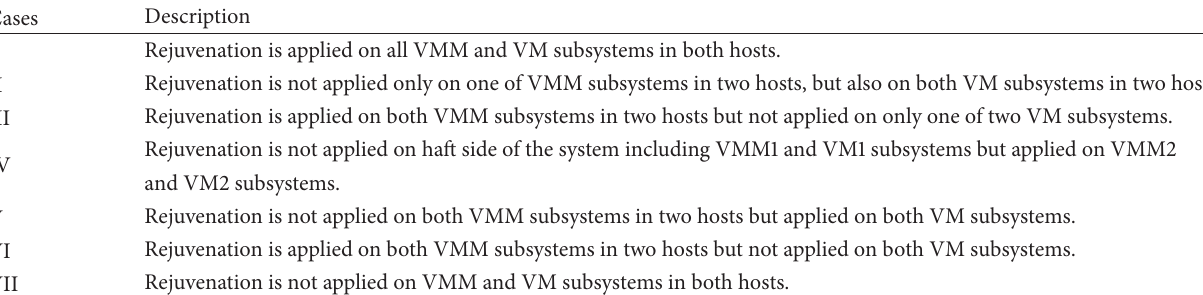
Table 4: Description of case studies in steady state availability analysis.